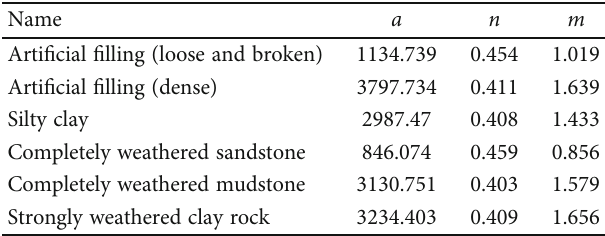
Table 2: Parameters of di ff erent types of rock and soil described by Fredlund-Xing soil-water characteristic